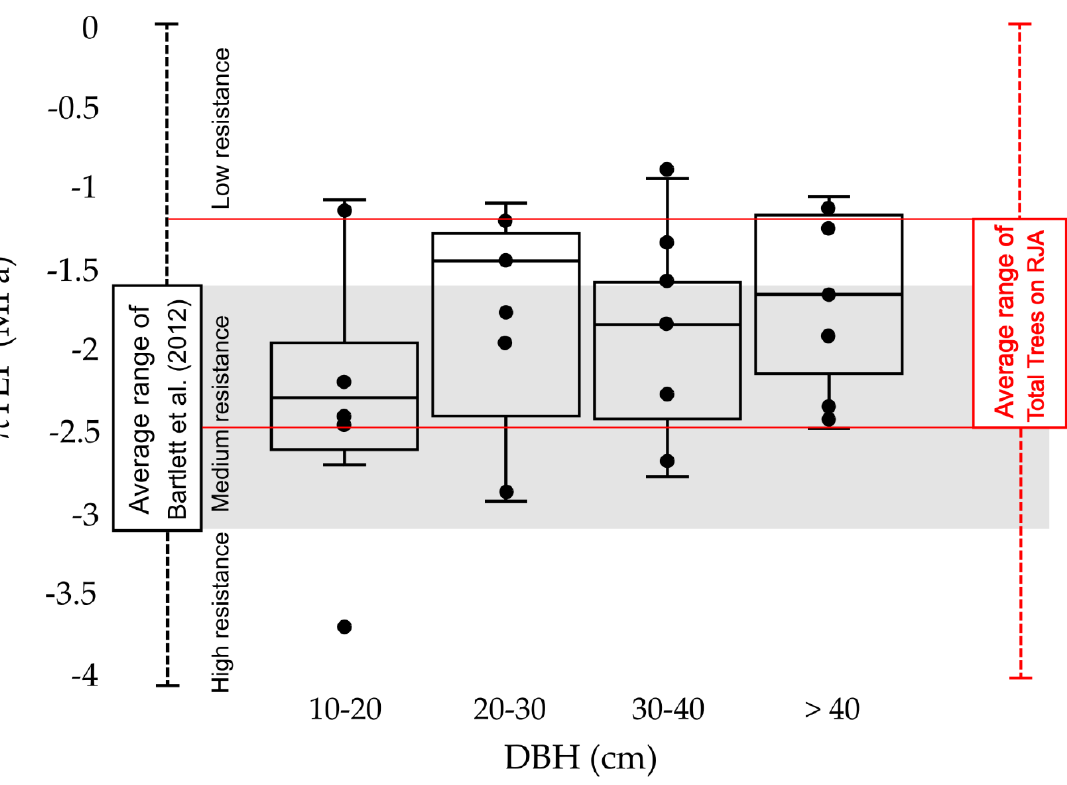
Figure 5. π TLP of the species sampled by diameter (DBH). Threshold based on Figure 5. πTLP of the species sampled by diamete r (DBH). Threshold based on [38].